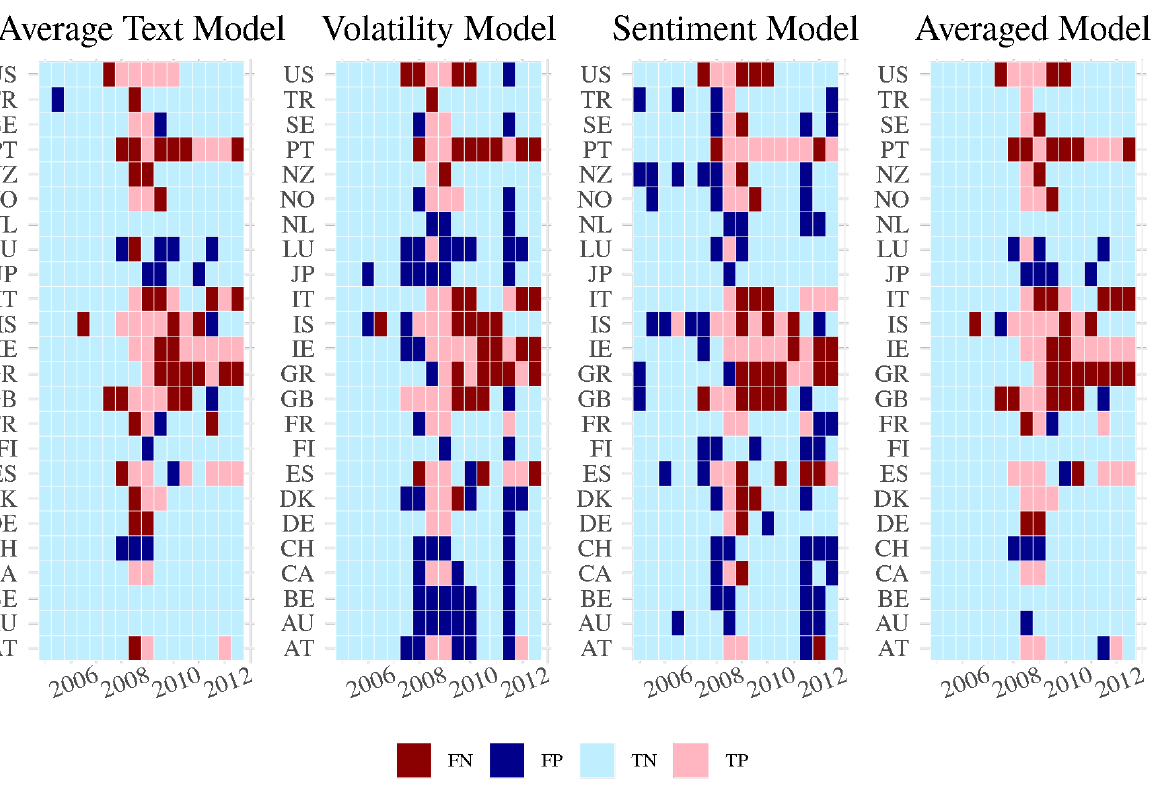
Figure 8. Confusion Matrix for R&R Minor Crises on OECD Text . Note: This figure shows confusion matrices for the out-of-sample period of 2005–2012 at the true positive rate (TPR) threshold of 55 percent for models predicting Romer and Romer (2017) 5+ severity crises trained on OECD text from 1981–2004. The confusion matrices indicate whether the model crisis classification for each country and time period (half year) is a False Negative (FN), False Positive (FP), True Negative (TN), or True Positive (TP). The lighter colors in the confusion matrix indicate better out-of-sample performance. The results show that the Average Text Model and Averaged Model outperform the Volatility and Sentiment Models. The Average Text Model performs perfectly for the Netherlands, Canada, Belgium, and Australia, while the Averaged Model performs perfectly for Turkey, the Netherlands, Finland, Denmark, Canada, and Belgium. Country abbreviations are as follows: United States (US), Turkey (TR), Sweden (SE), Portugal (PT), New Zealand (NZ), Norway (NO), Netherlands (NL), Luxembourg (LU), Japan (JP), Italy (IT), Iceland (IS), Ireland (IE), Greece (GR), United Kingdom (GB), France (FR), Finland (FI), Spain (ES), Denmark (DK), Germany (DE), Switzerland (CH), Canada (CA), Belgium (BE), Australia (AU), Austria